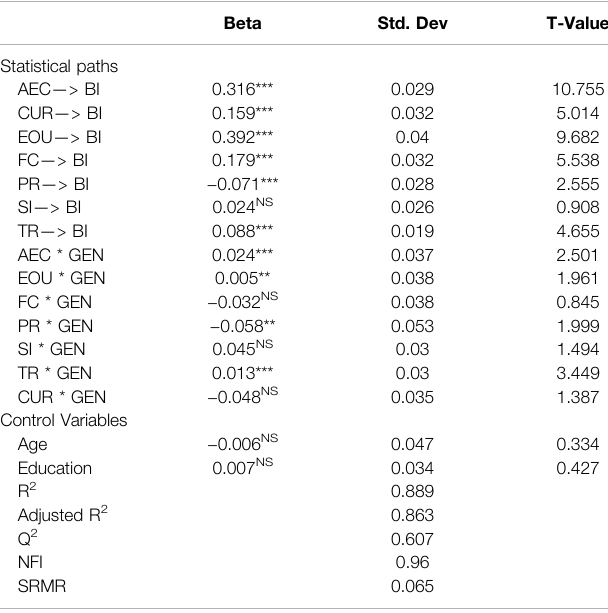
TABLE 5 | Model 2 (Moderation